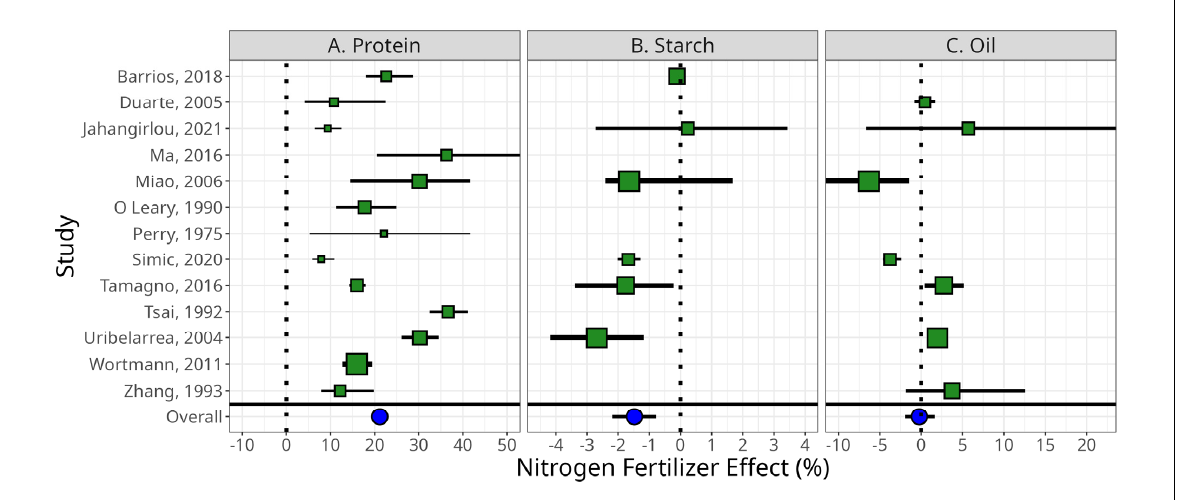
Figure 4. Summary of N fertilizer effect (%) on maize grain quality components (( A )—Protein, ( B )—Starch, and ( C )—Oil). Effect sizes and 95% confidence intervals (CI) were transformed from lnRR into percentage [(exp(lnRR) − 1)*100], as the concentration variation in water-stressed with respect to well-watered control. Within each variable, green square symbols represent the mean effect per study, while shape size and whiskers their represent respective weights and uncertainties, respectively. Blue circles represent the overall random effects model with their respective uncertainties.